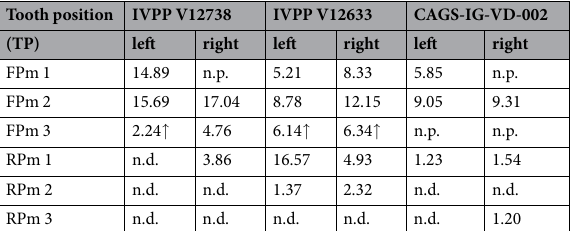
Table 1. Premaxillary teeth in Liaoceratops yanzigouensis. n.p. = not preserved. n.d. = not developed. ↑ = the true size should be higher as the crowns were lost. All measurement in